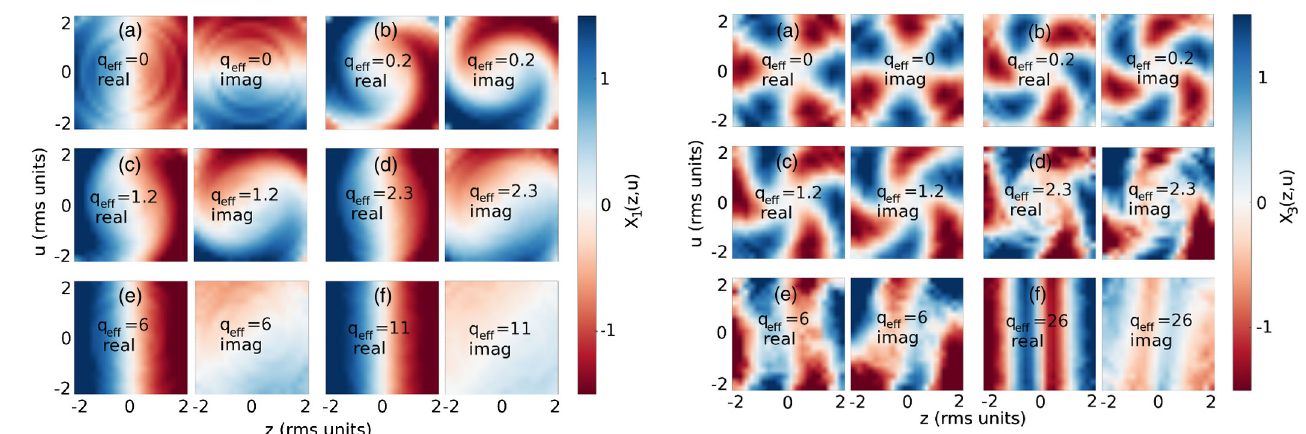
X ð z; u Þ can be described 3 eff